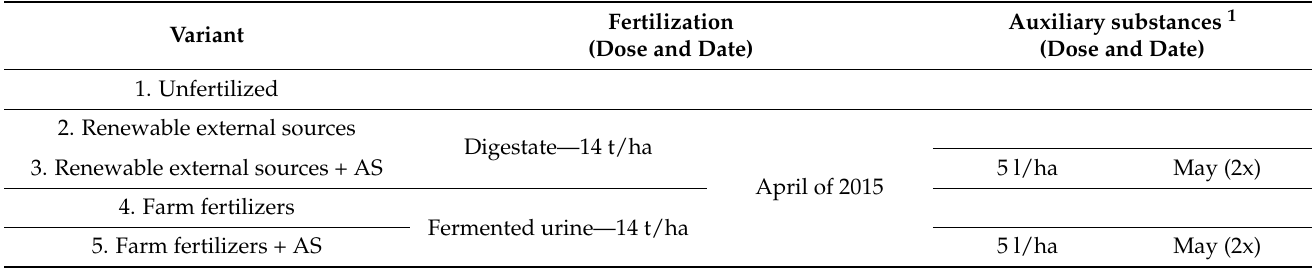
Table 3. Fertilization of winter wheat (2014–2015).